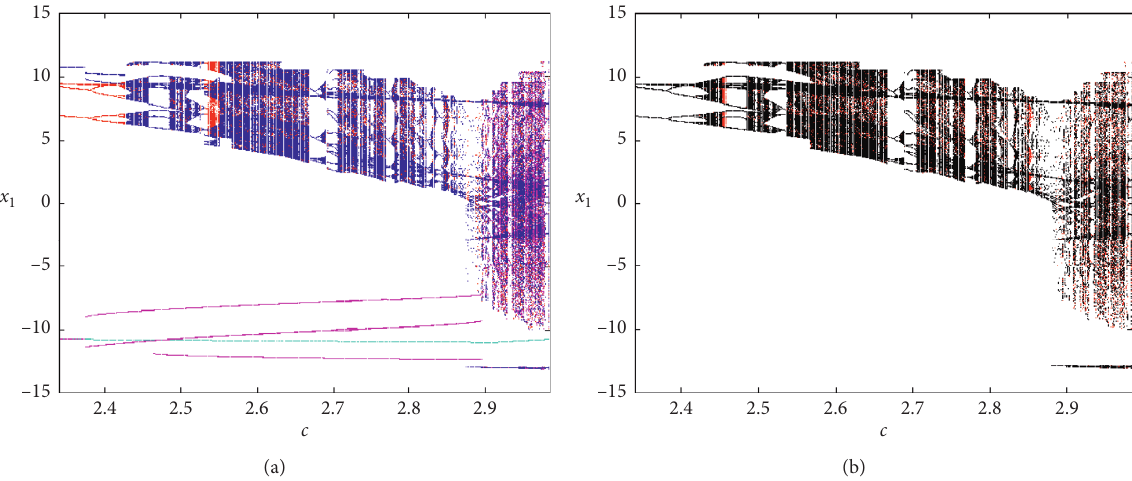
Figure 8: symmetric coexisting bifurcation diagrams showing complex structure of the new hyperjerk for a � 1.8, b � 3.8, d � 1.35, e � 14.85, and m � 2 . 2. Initial conditions y ( 0 ) � z ( 0 ) � w ( 0 ) � 0 and x ( 0 ) are fixed as follows for obtaining these diagrams: red diagrams for increasing c with x ( 0 ) � 5 . 25, black diagram for decreasing c with x ( 0 ) � − 10, cyan diagrams for increasing c with x ( 0 ) � − 10 . 67, magenta diagram for increasing and decreasing, started at c � 2 . 5442 with x ( 0 ) � − 4, and blue diagram for starting c with same initial condition x ( 0 ) � c . For more information, see Table